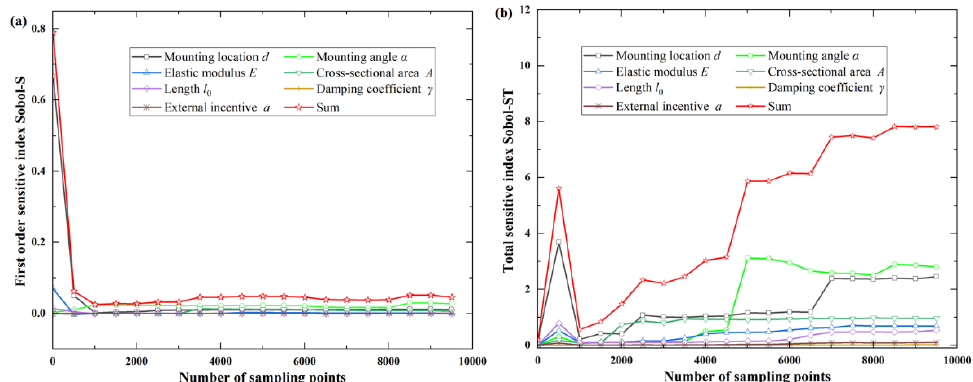
Figure 5. First-order and total sensitive index for objective function f 3 ( X ): ( a ) first-order sensitive index Sobol − S; ( b ) total sensitive index Sobol − ST.